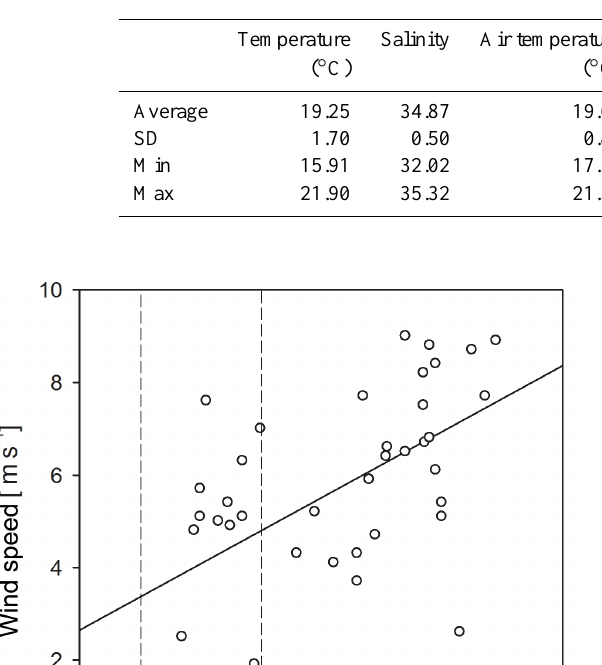
Table 1. Hydrographic conditions encountered during SML sampling off the coast of Peru in 2012 (M91). Data on air temperature, wind speed, global and UV radiation were obtained from the ship’s DShip database for the time of sampling.